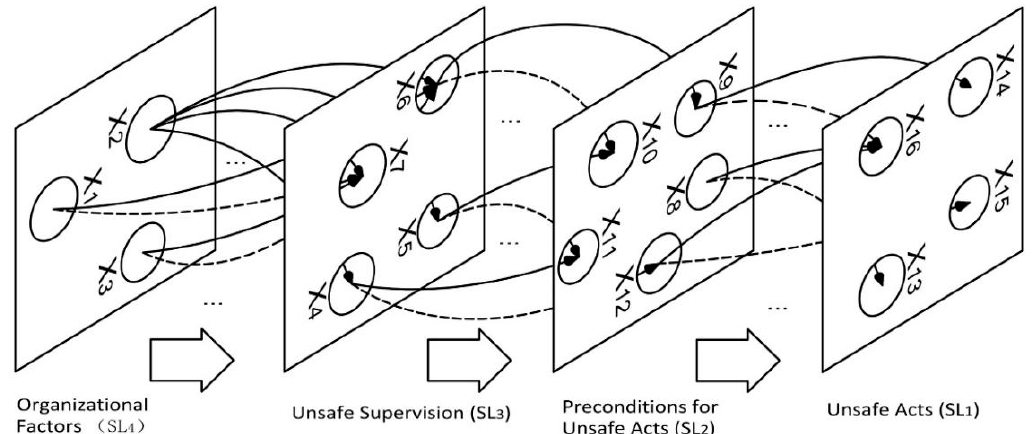
Figure 1. Path model of causal factors chain to marine accidents based on the HFACS.